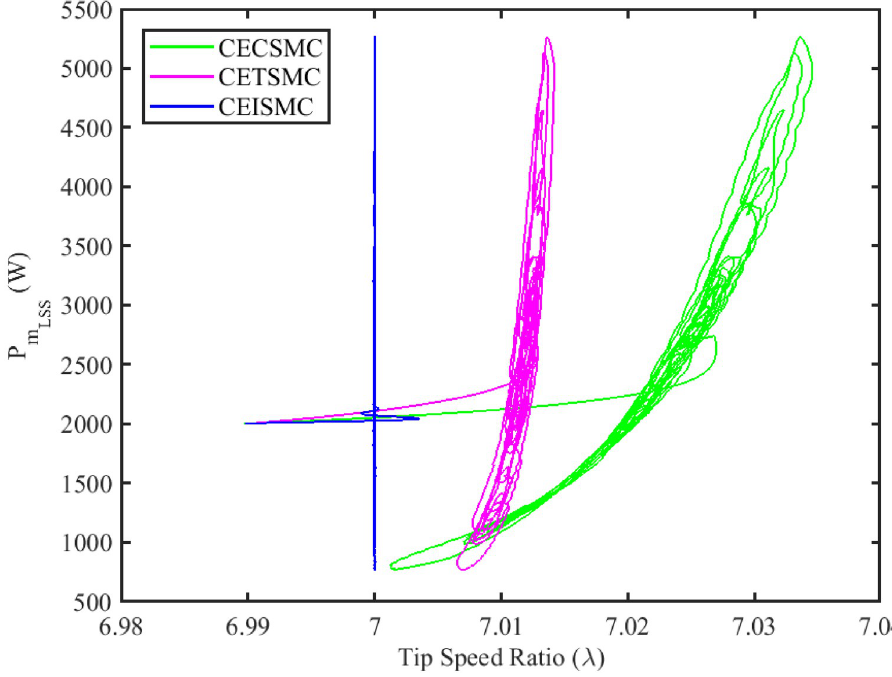
Fig 7. Tip speed ratio versus low speed shaft